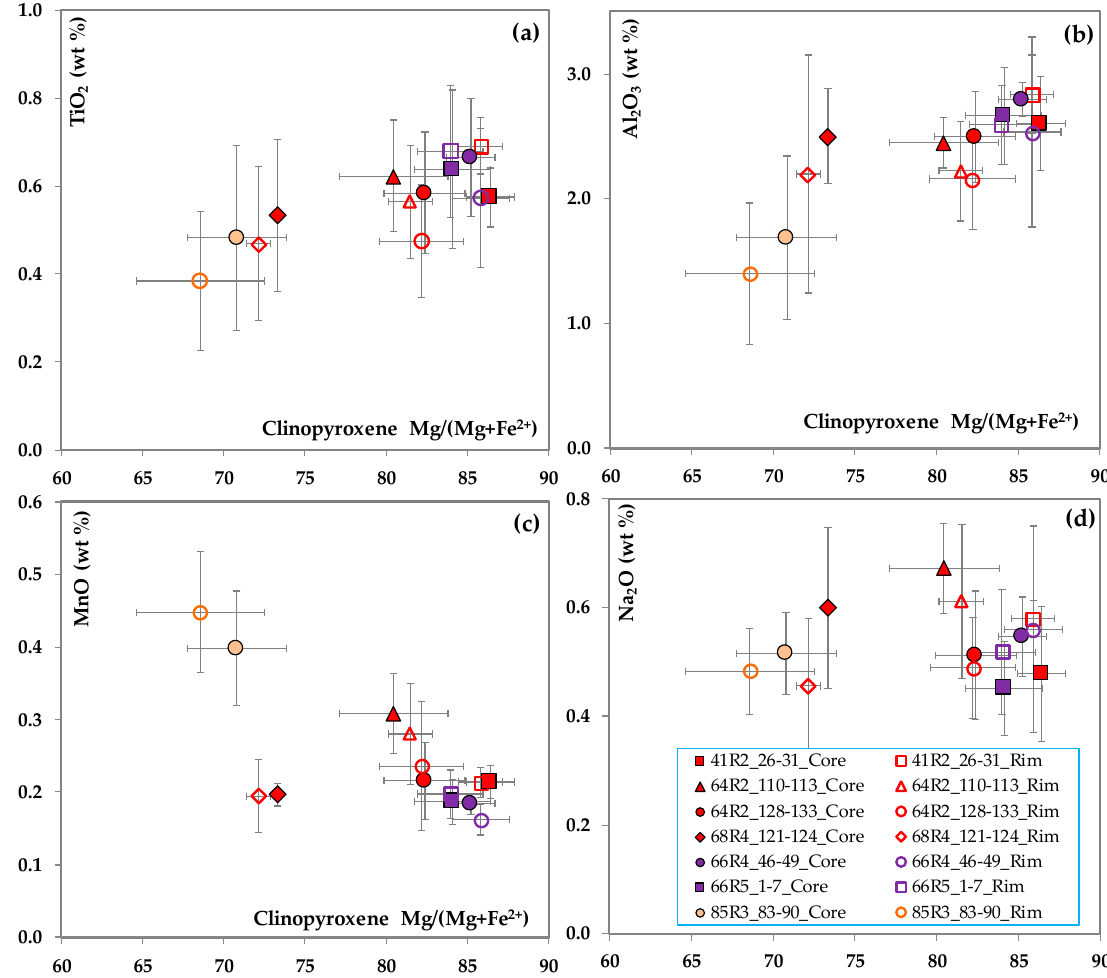
Figure 10. Clinopyroxene Mg# versus minor element oxides. ( a ) Mg# versus TiO 2 . ( b ) Mg# versus Al 2 O 3 . ( c ) Mg# versus Na 2 O. ( d ) Mg# versus MnO. Each symbol is the average composition of 1 thin section; solid–open symbols indicate the average composition of the cores and rims, respectively. Bars are 1 σ standard deviations.